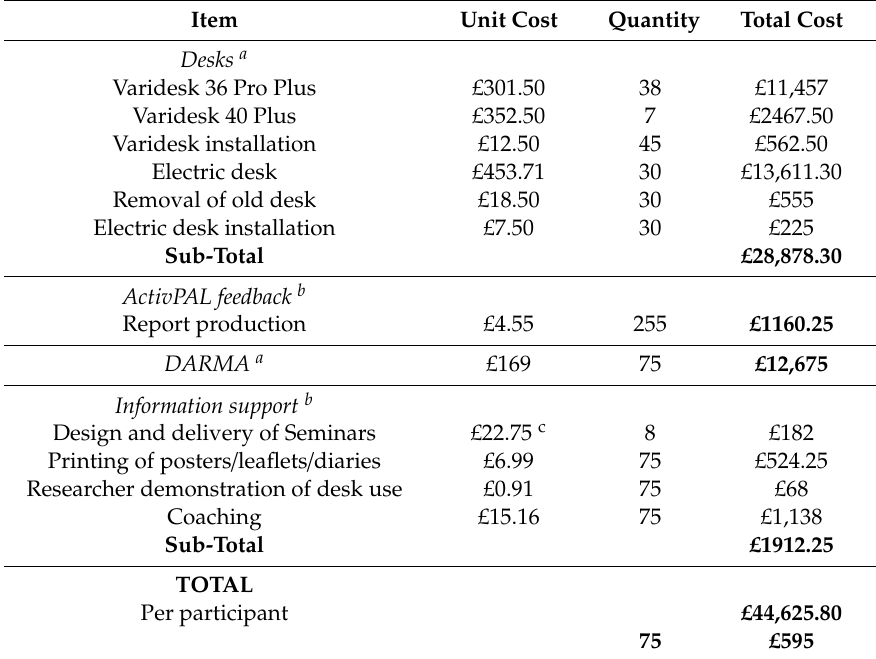
Table 1. Intervention cost breakdown: Materials and facilitator time.